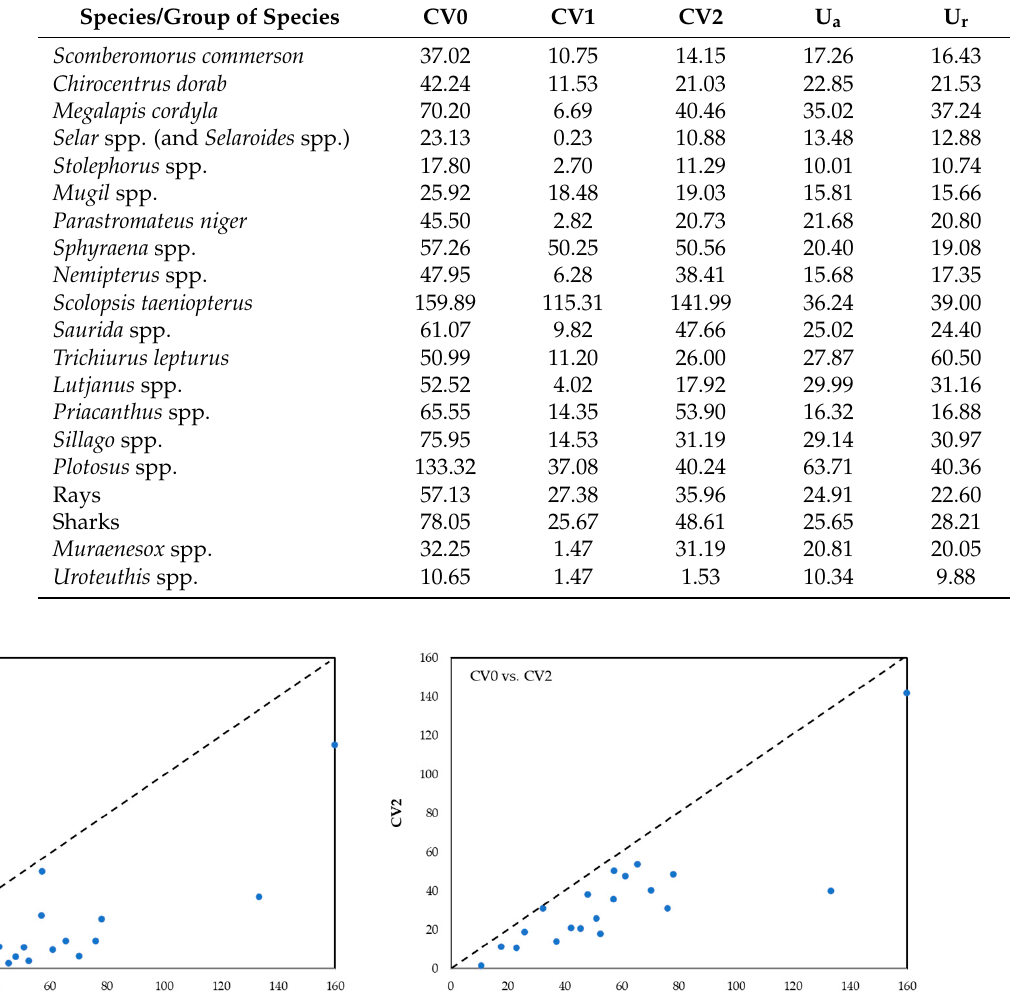
Table 4. Coefficient of variation (%) for zero- (CV0), first- (CV1) and second- (CV2) order polynomials and indices (%) for absolute (U a ) and relative (U r ) short-time variations in fish landings of high and considerably high vulnerability species/groups of species from trawl fisheries in the Gulf of Thailand.